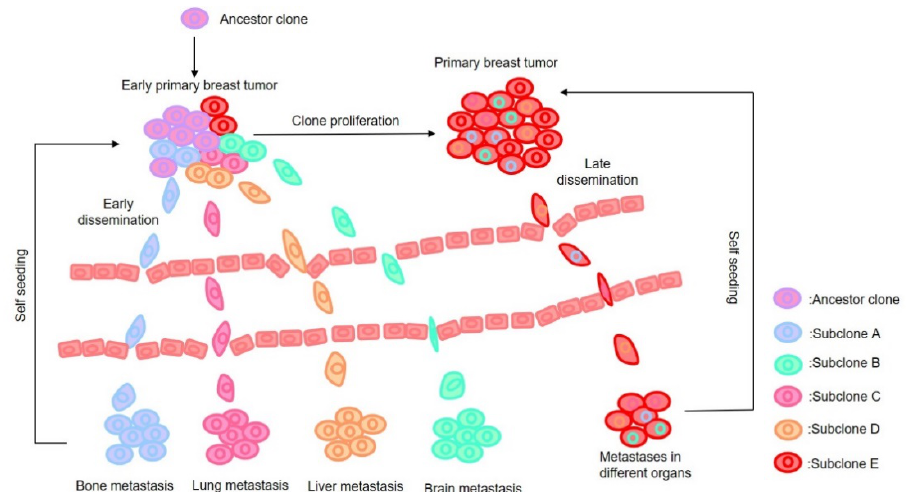
Figure 1. Models of metastasis evolution for BC. Based on current data, we propose a common ancestor clone and late dissemination versus an early dissemination model. Only a small fraction of tumor cells in primary site are capable of metastasizing (subclone A\B\C\D). Tumor cells can acquire oncogenic events that determine its metastatic tendency and shed from primary tumor very early. BC cells within an individual patient is heterogeneous (early primary breast tumor and primary breast tumor) and tumor cells with poor-prognosis signature (subclone A\B\C\D) are more likely to metastasize than tumor cells with good-prognosis signature (ancestor clone \ Subclone E). Tumor cells derived from metastatic organ can reseed into local site.